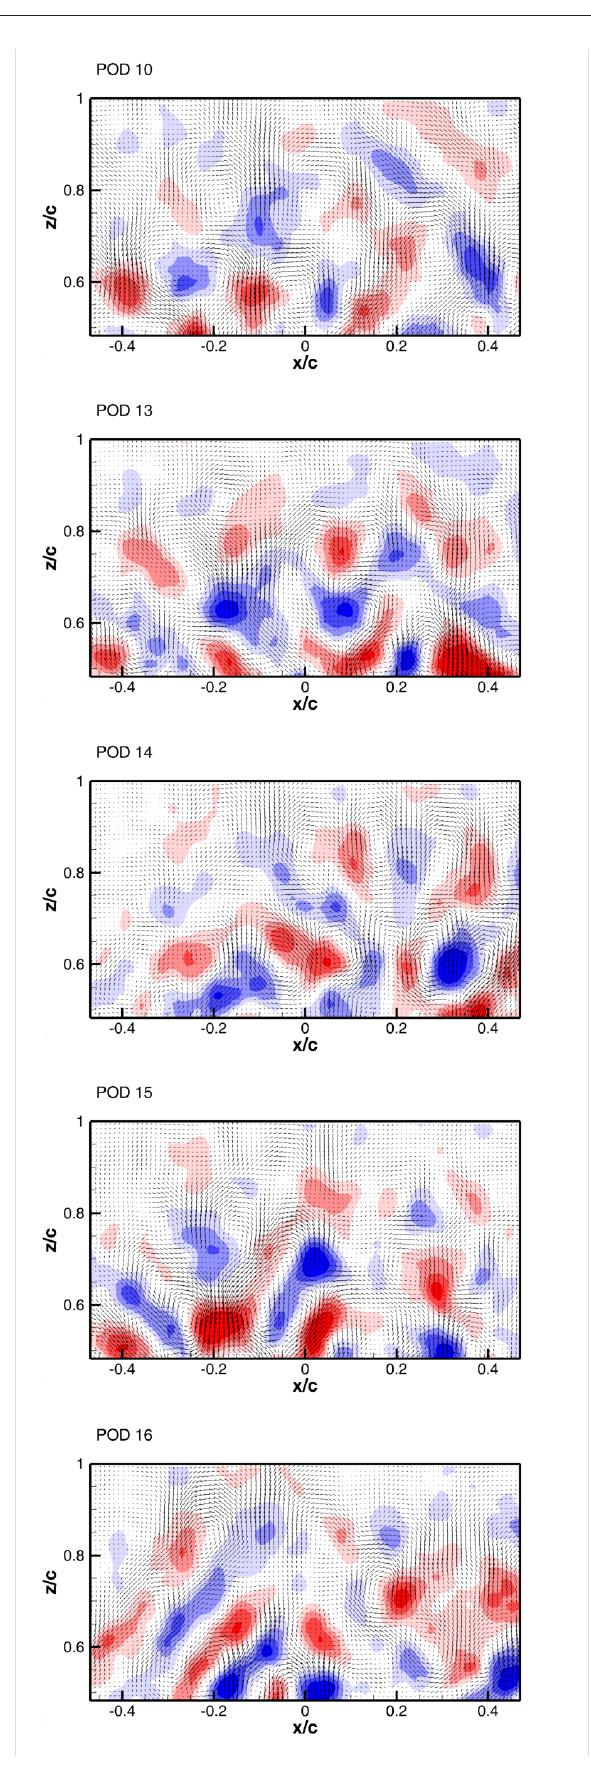
Fig. 13. Examples of POD modes, measuring plane 2